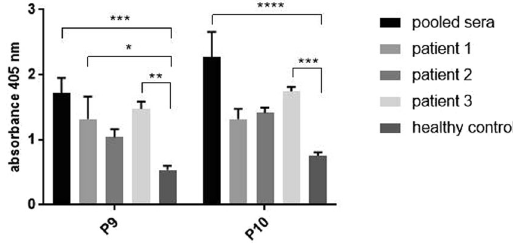
Figure 7. Reactivity of sera from patients with autoimmune disease with C. difficile peptides P9 and P10. Figure shows results from at least three independent measurements, means with SD, data was analyzed using 2way ANOVA * P < 0.05; ** P < 0.01; *** P < 0.001; **** P <